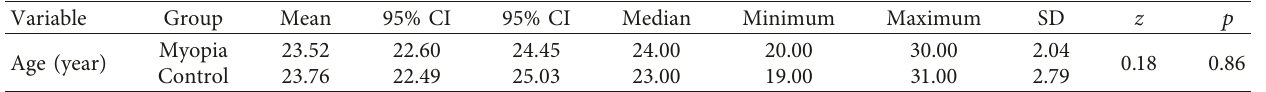
Figure 3: Electrodes placement during the electromyographic examination. TA: temporalis muscle (the anterior part), MM: the masseter muscle (the superficial part), DA: the digastric muscle (the anterior belly), and SCM: the sternocleidomastoid muscle (the middle part). Table 1: Comparison of age between